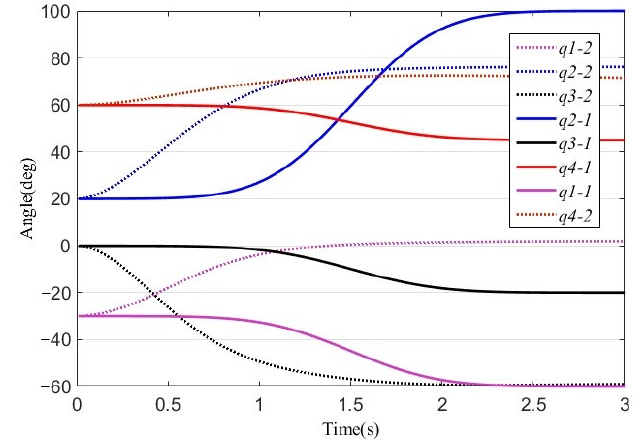
Figure 14. Comparison chart of angles change process under the controllers.